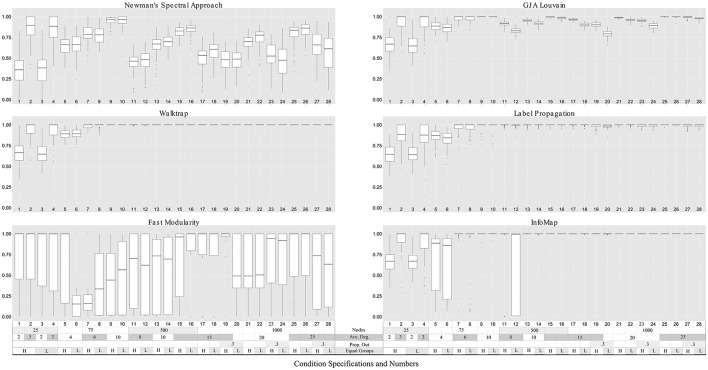
Community precision for LFR count matrices. Simulation numbers correspond to those described in Table 2. In the legend depicting the simulation parameters appended at the bottom of the graph, “Ave.” indicates average, “Prop. Out” indicates the proportion of edges that connect nodes with other nodes outside their community (“mixing parameter,” “L,” and “H” indicates low and high number of equally-sized groups (“community distribution exponent”), respectively. No approach could reliably return community structures in count matrices with nodes = 25. Walktrap and Label Propagation consistently performed nearly perfectly for count matrices with nodes = 500 and higher.